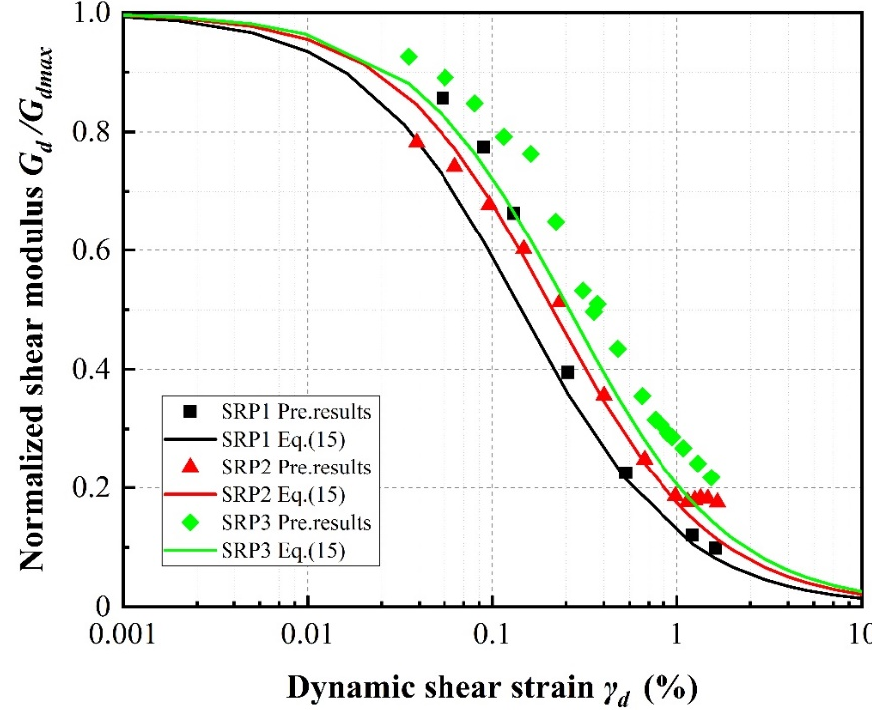
Figure 22. Normalized shear modulus versus shear strain for 20% rubber volume content under 100 kPa confining pressure according to rubber particle size.